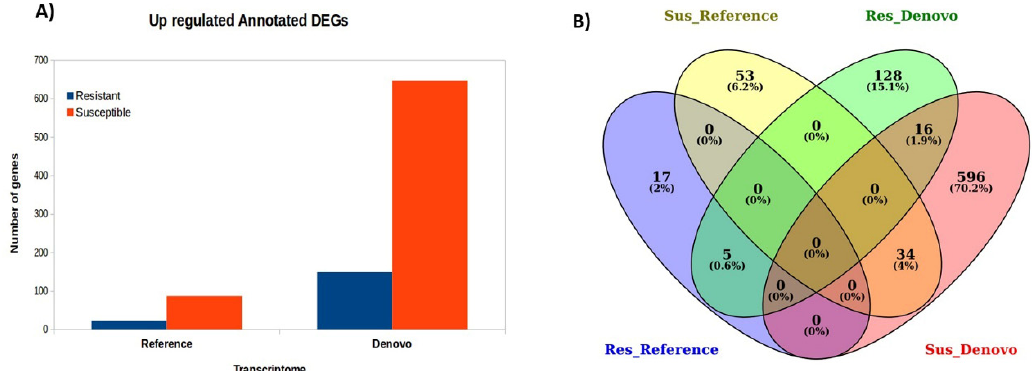
Figure 2. Summary of differential gene expression and comparison: ( A ) the number of differentially expressed transcripts identified using reference-based assembly and de novo based assembly; ( B ) Venn diagrams of the number of differentially expressed transcripts for pairwise comparisons at a false discovery rate (FDR) of <0.05.